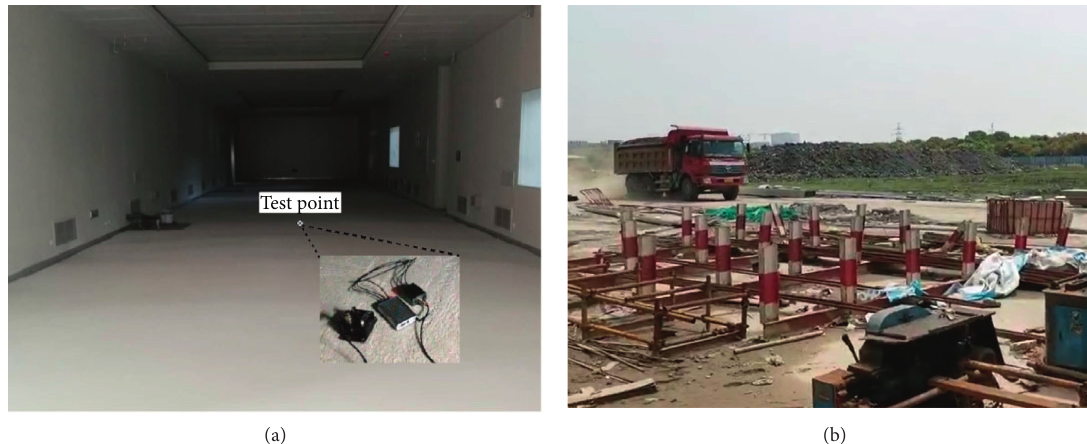
Figure 7: Vibration measurement of the designed antivibration foundation: (a) high-tech lab, (b) passage of a heavy truck on the road.